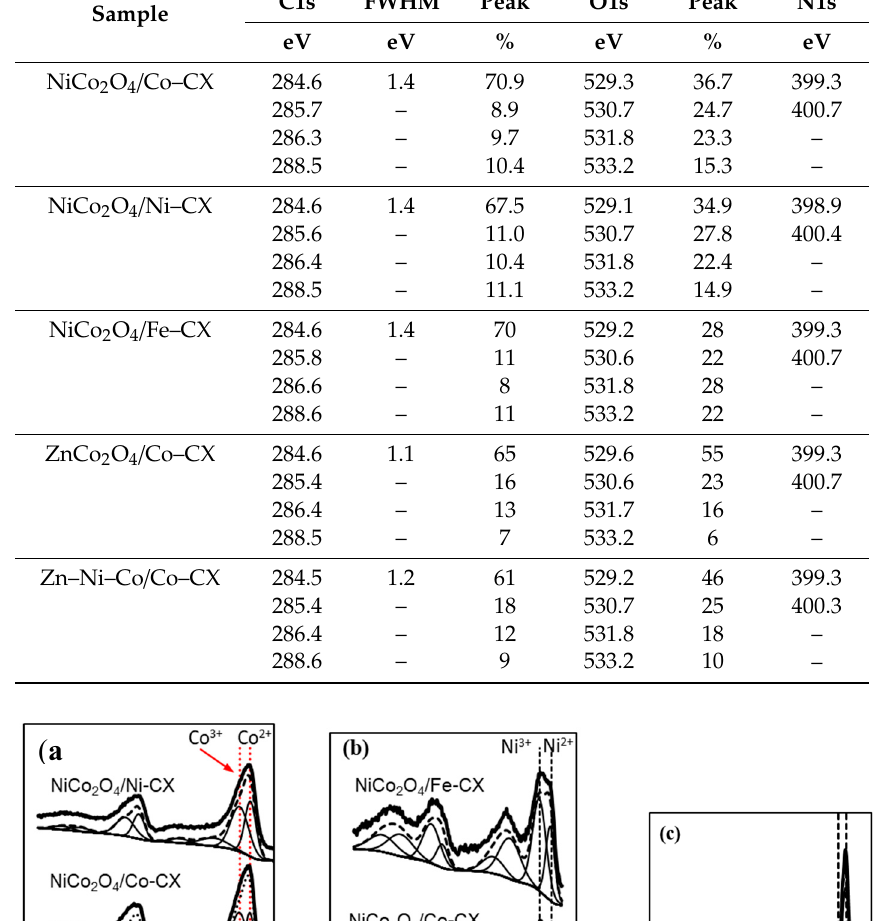
Table 3. Binding energies of C1s, O1s, and N1s regions.